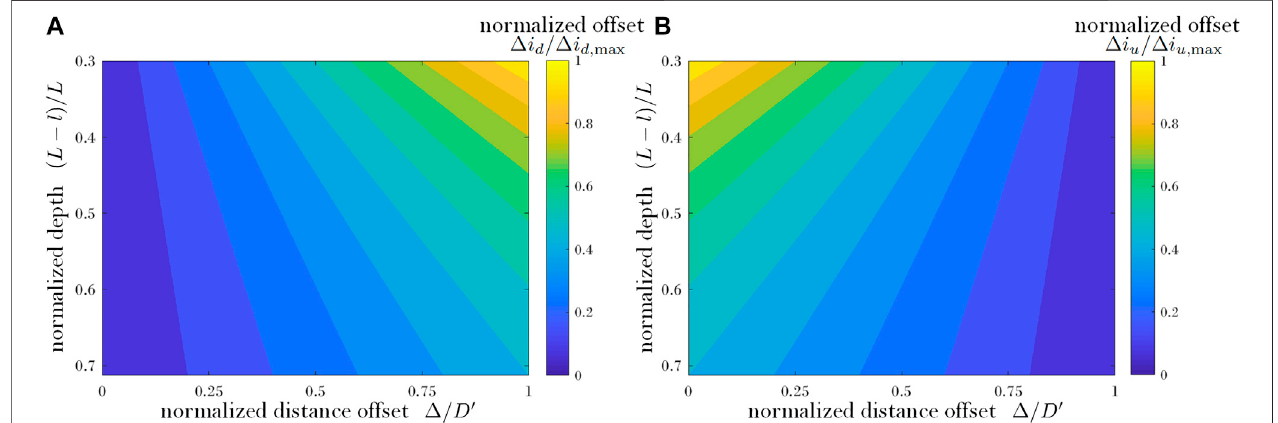
FIGURE 4 | Normalized offsets for pixel positions with different system parameters: (A) Δ i d / Δ i d , max and (B) Δ i u / Δ i u , max .